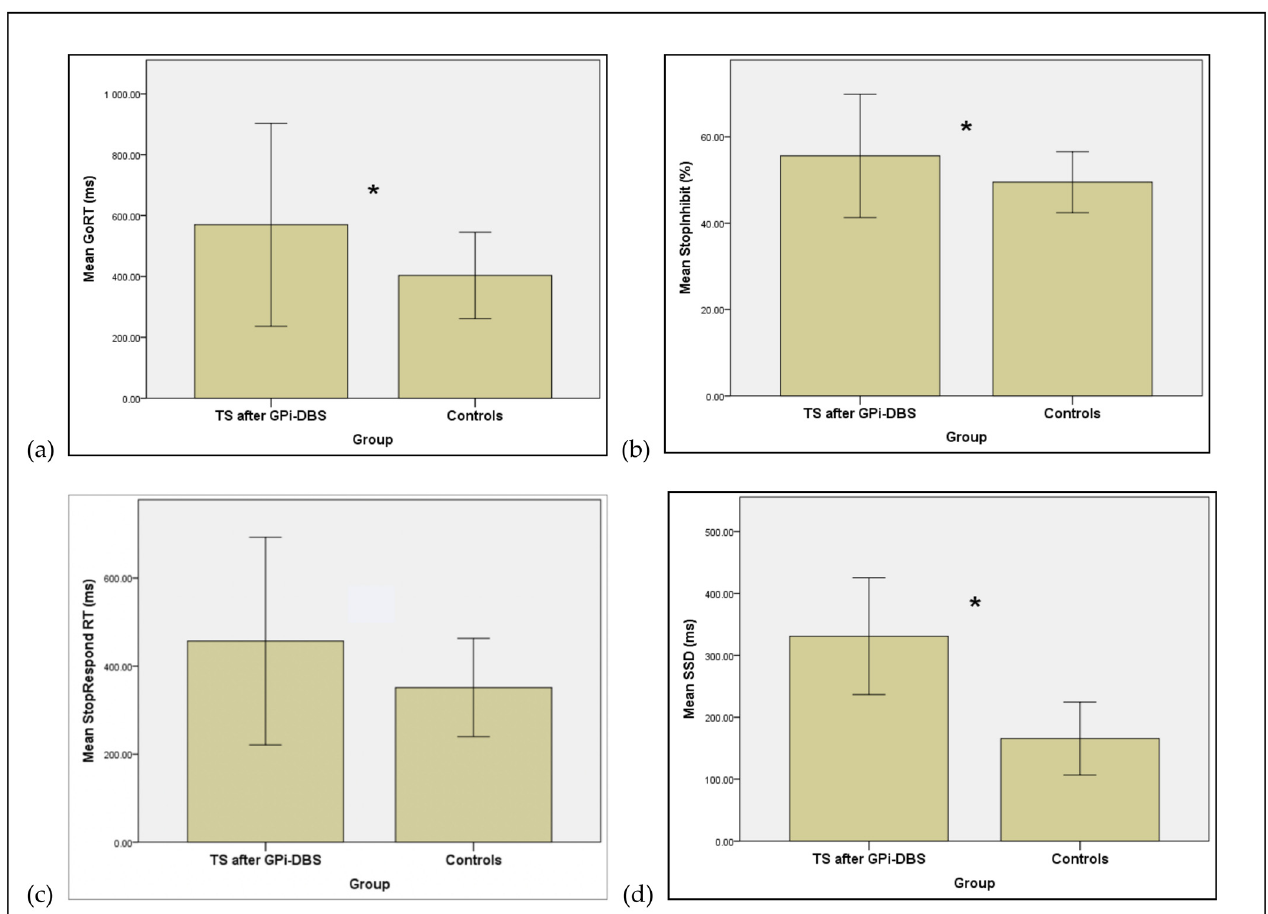
Figure 2. Mean measures for patients with Tourette syndrome (TS) after deep brain stimulation of the internal segment of the globus pallidum (GPi-DBS) and healthy controls. ( a ) Mean Go RT (ms) ( b ) Mean Stop Inhibition (percentage trials with correct inhibition) ( c ) Mean Stop Respond RT (StopRespond RT, ms) ( d ) Mean Stop Signal Delay (SSD, ms). Error bars represent standard errors of the mean. * Significant difference p < 0.002.